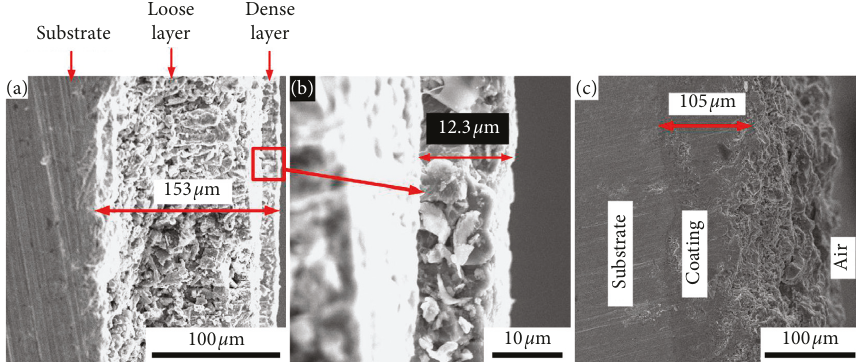
Figure 1: Cross section of the 20CrMnTi uncoated and coated samples after reheating. (a) Uncoated sample; (b) magnification of the dense layer; (c) coated